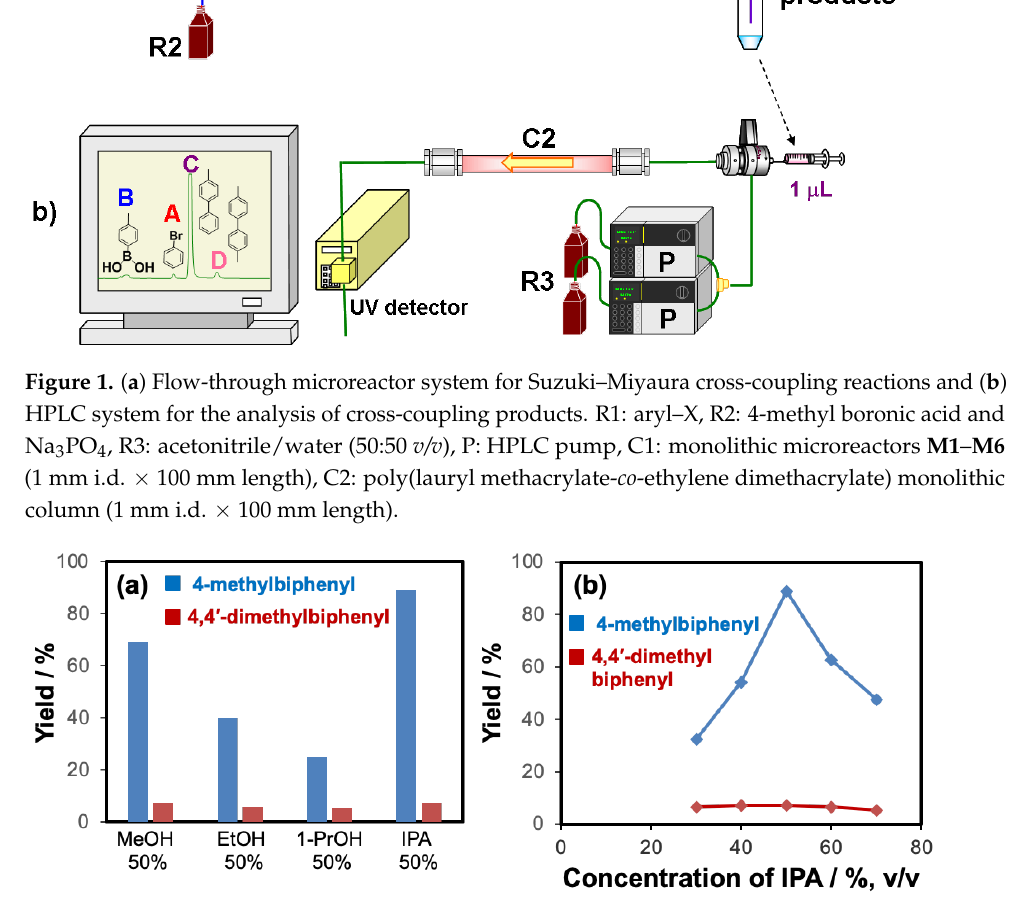
Figure 2. Effect of solvent ( a ) and ( b ) concentration of IPA on the reaction of bromobenzene with 4-methylphenylboronic acid using the microreactor M1 . Reaction time inside M1 was 12 s, and reaction temperature was 27 ◦ C. MeOH: methanol, EtOH: ethanol, 1-PrOH: 1-propanol, IPA: isopropyl alcohol. Mole ratio of bromobenzene/4-methylphenylboronic acid/Na 3 PO 4 = 1:1:1. Table 2. Optimization of the mole ratio of cross-coupling reagents and base.